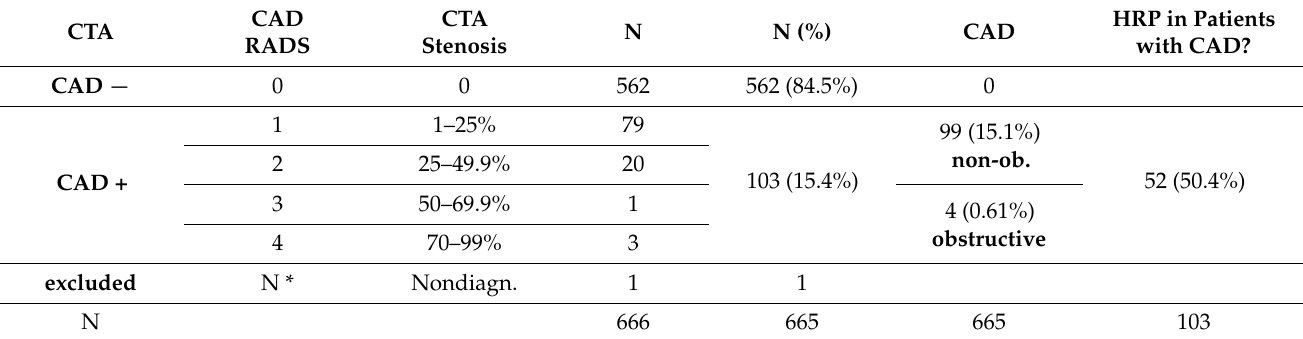
Table 3. CTA results in 666 patients with CACS 0.